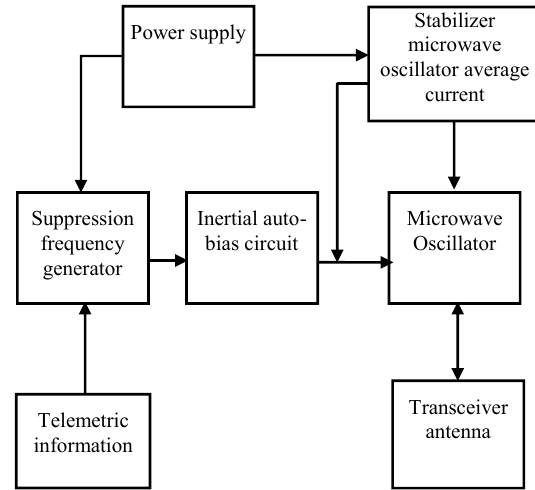
Fig. 1. Block diagram of super-regenerative radiosonde